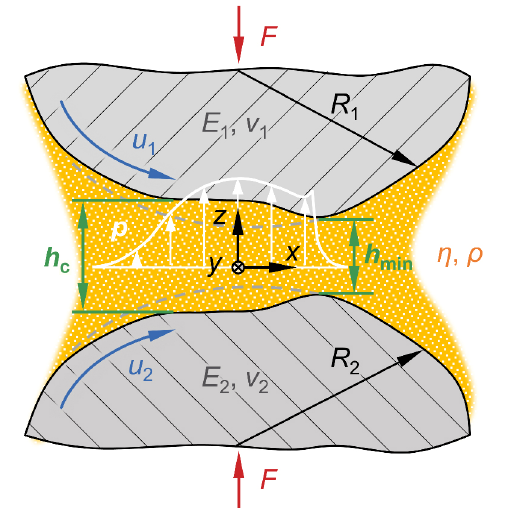
Fig. 1 Schematic of an EHL infinite 2D line contact with relevant input variables. Reproduced with permission from Ref. [4], © The authors